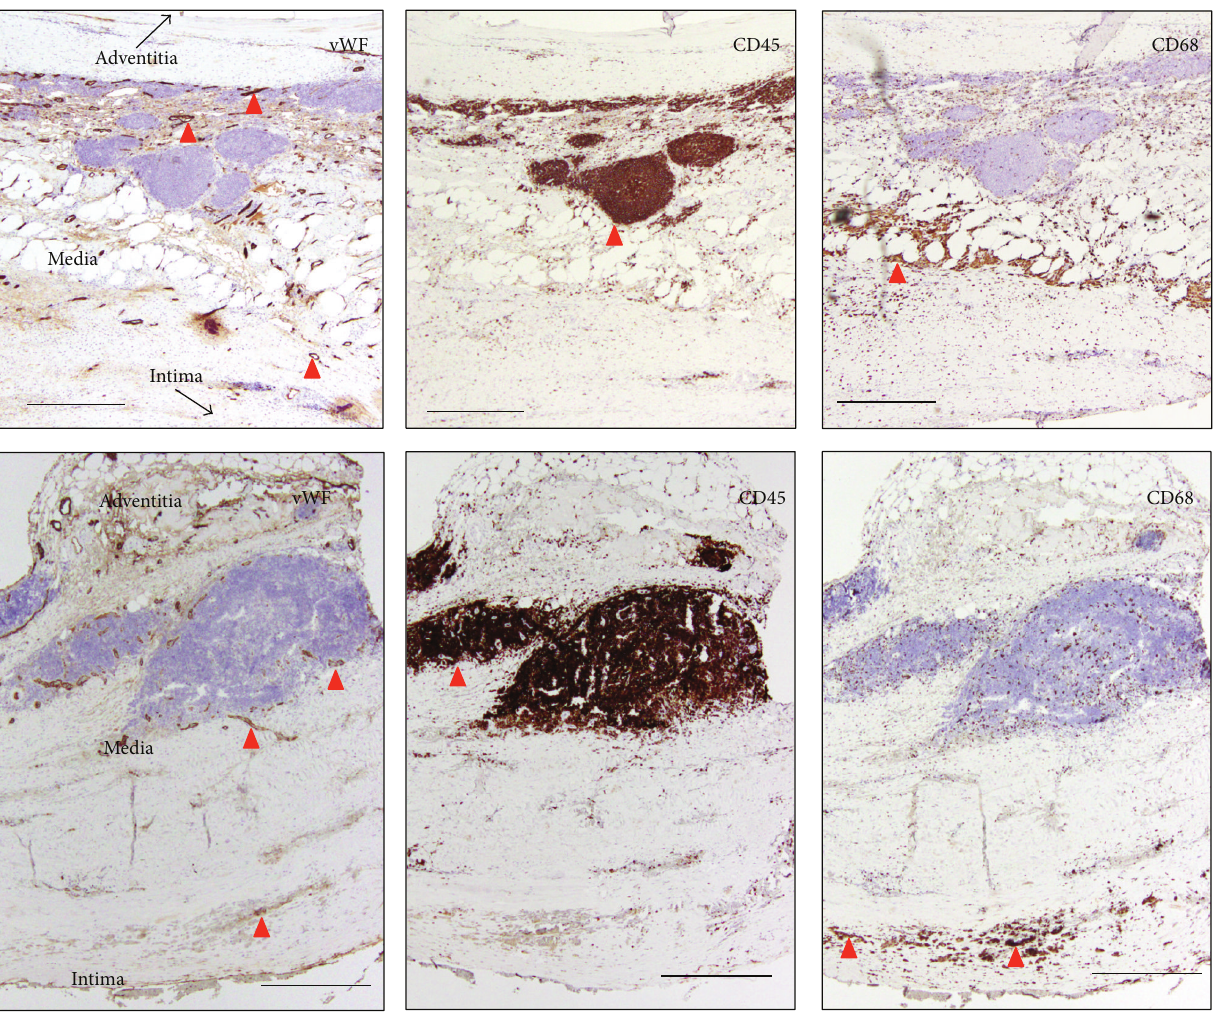
Figure 1: Representative immunohistochemical images of vWF (endothelial cell marker), CD45 (pan-leukocyte marker), and CD68 (macrophage marker) in aorta samples from two AAA patients. Red arrow-ends indicate some immunostained cells. Size bars: 500 𝜇 m. In upper panels black-tipped arrows are used to orient the position of the vessel by indicating to where intima and adventitia